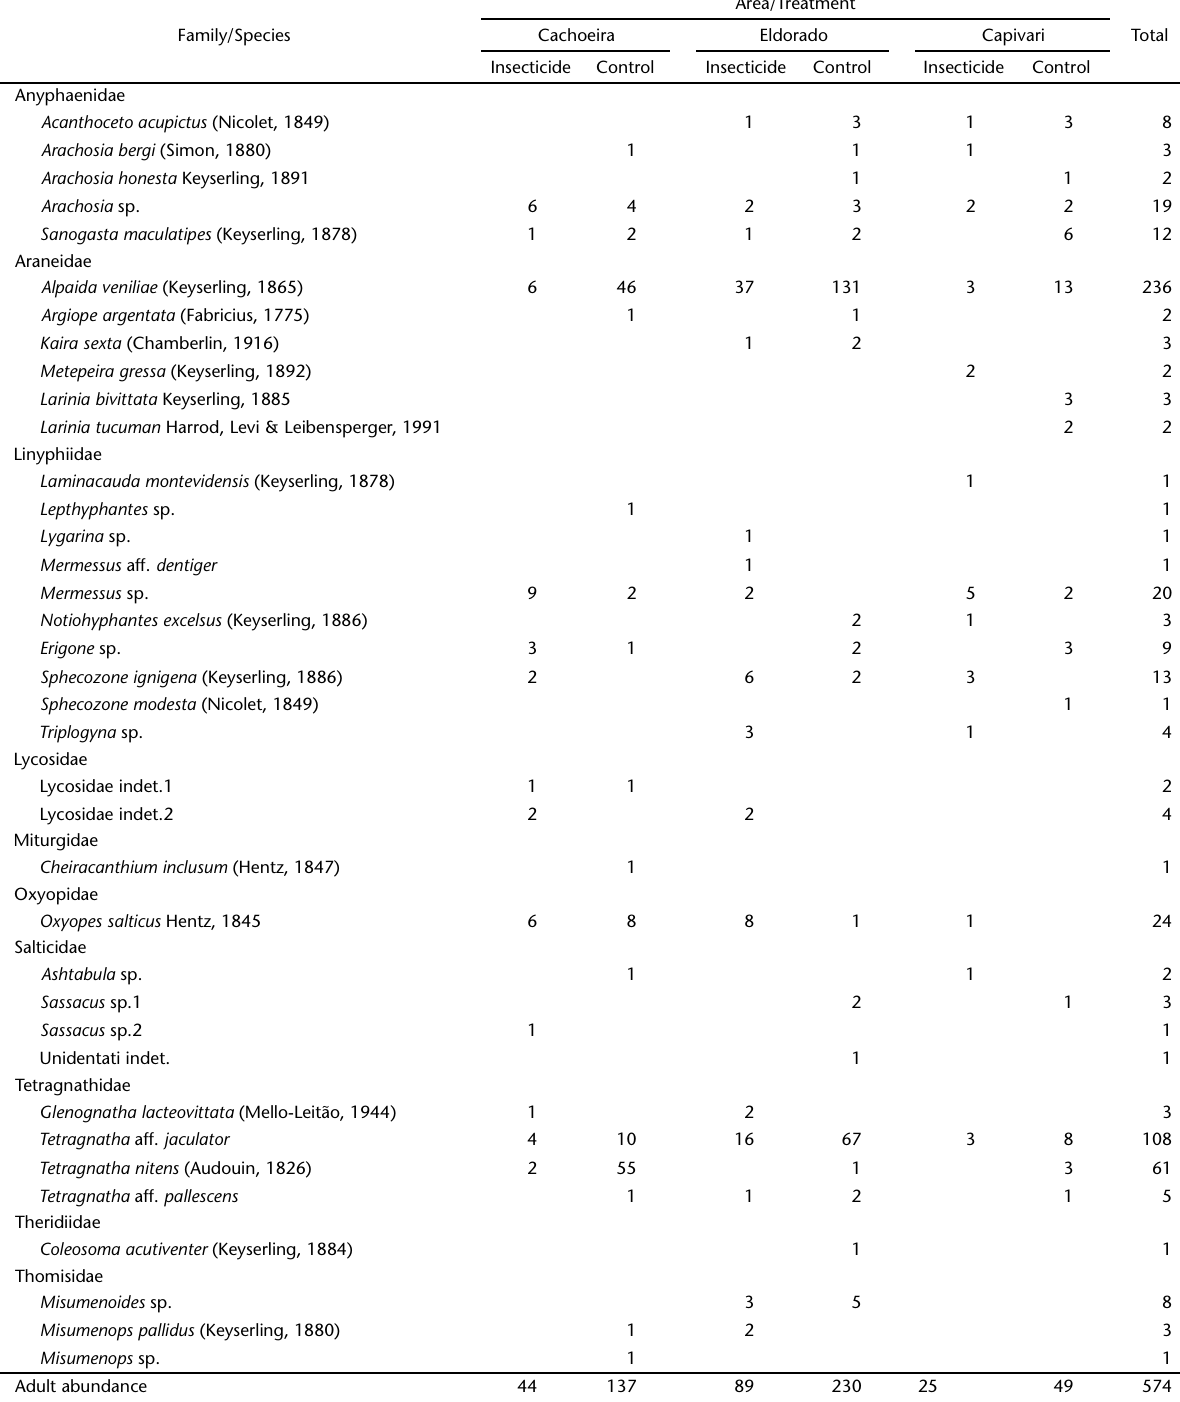
Table I. Number of adult spiders from sweep net sampling in plots treated with insecticide and untreated in three rice areas of Rio Grande do Sul, Brazil. Area/Treatment Family/Species TotalCachoeira Eldorado Capivari Insecticide Control Insecticide Control Insecticide